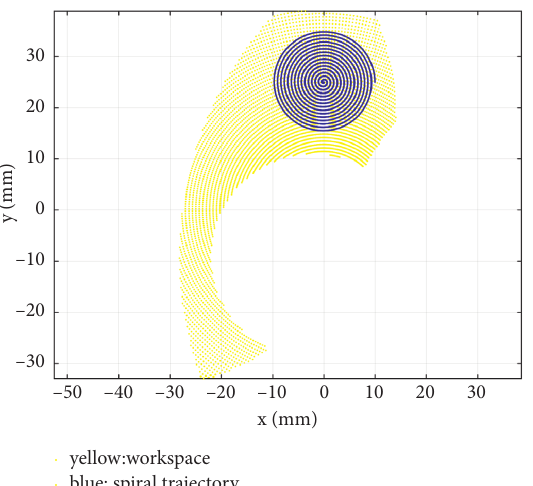
Figure 4: Workspace of the 3-RRR PPM and the spiral trajectory of central point G